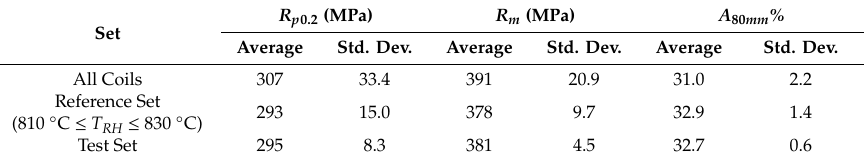
Table 9. Results of the on-line tests for Steel Code B and thickness range 3 (0.9–1.1 mm).